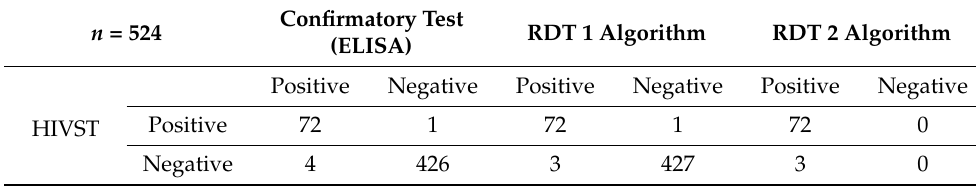
Table 4. Comparative test results of HIVST, ELISA and RDT Algorithm for RDT 1 and 2. n =